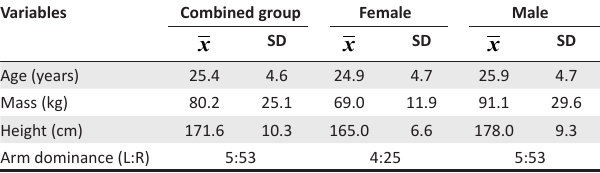
TABLE 1: Demographic and anthropometric information ( n = 58).